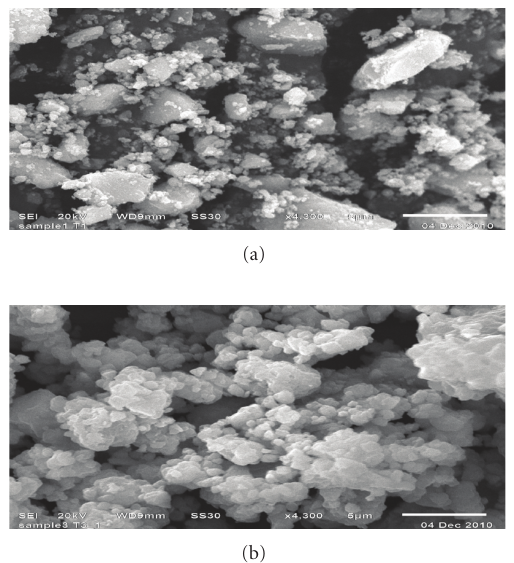
Figure 7: SEM images of (a) undoped TiO 2 and (b) 1.25 wt.% of Mg-doped TiO 2 .